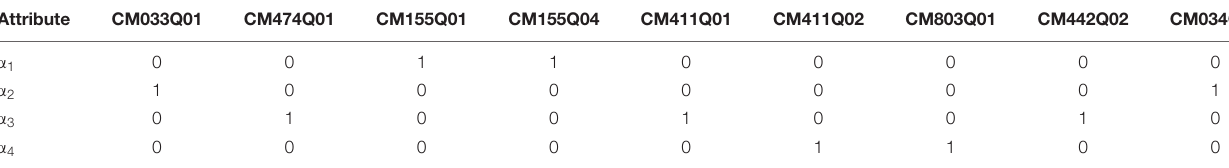
TABLE 7 | The Q matrix in the real data.